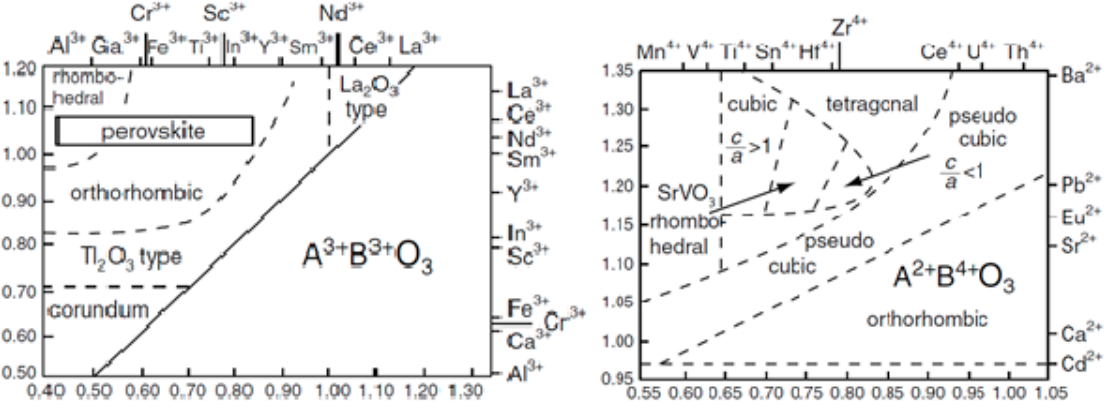
Figure 3. Effects of the ionic size of A and B cations on the distortions observed in the crystal structure of perovskite for A 2+ B 4+ O 3 and A 3+ B 3+ O 3 combinations (Adapted from [25]).